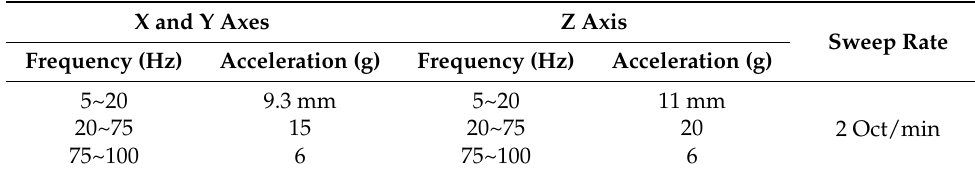
Table 4. Qualification sine vibration load case.